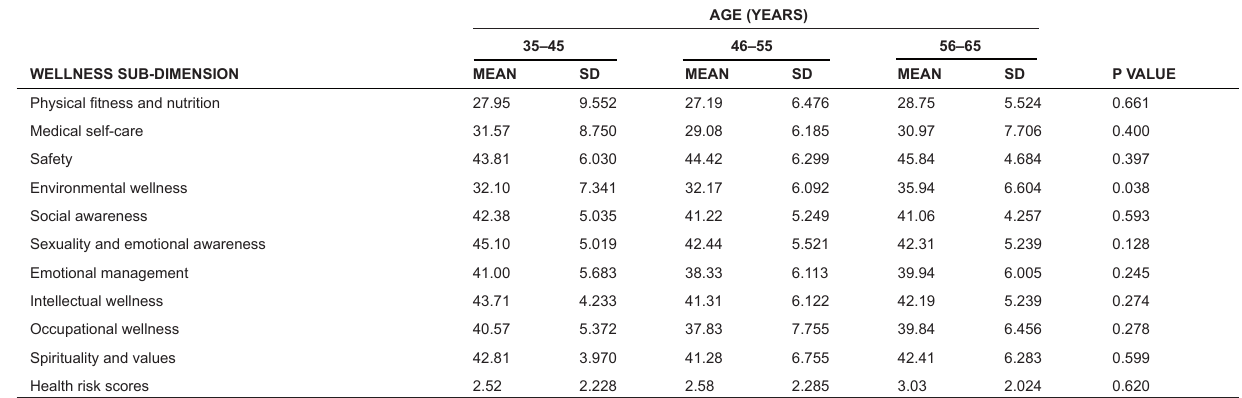
TABLE 4 ANOVA to compare the mean scores of the wellness behaviour levels and health risk scores between the three age groups